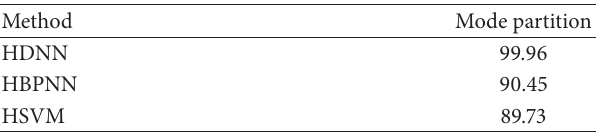
Table 6: The classification results by the second hierarchical of the proposed